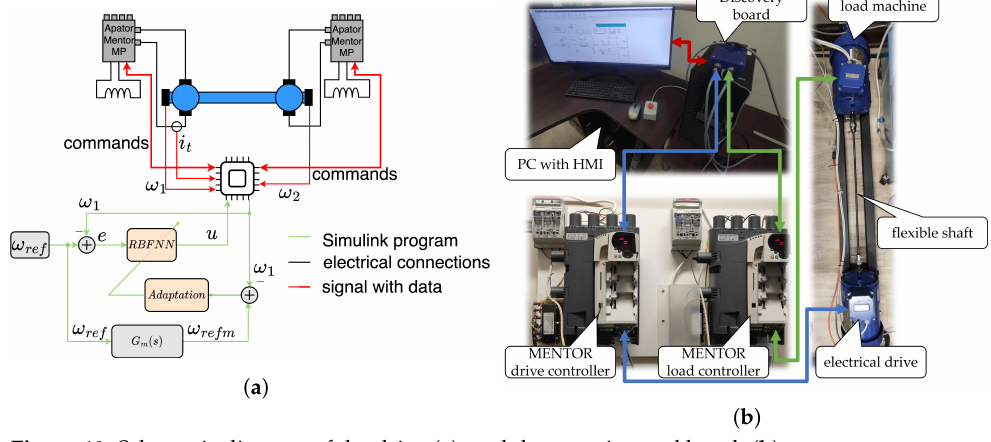
Figure 13. Schematic diagram of the drive ( a ), and the experimental bench ( b ).